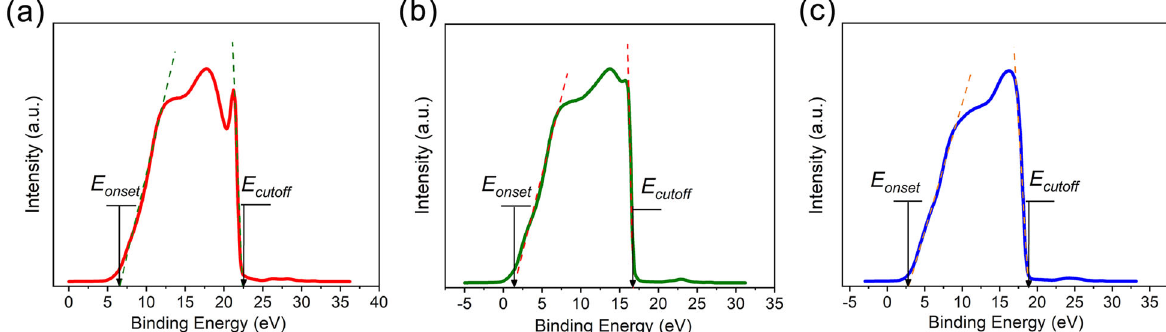
Fig. 4 The electrical properties of 2D semoconductor fi lms. The evaluated UPS spectrum obtained from the printed a 2D-Ga 2 O 3 , b In 2 O 3 , and c SnO to identify their electron af fi nity value.